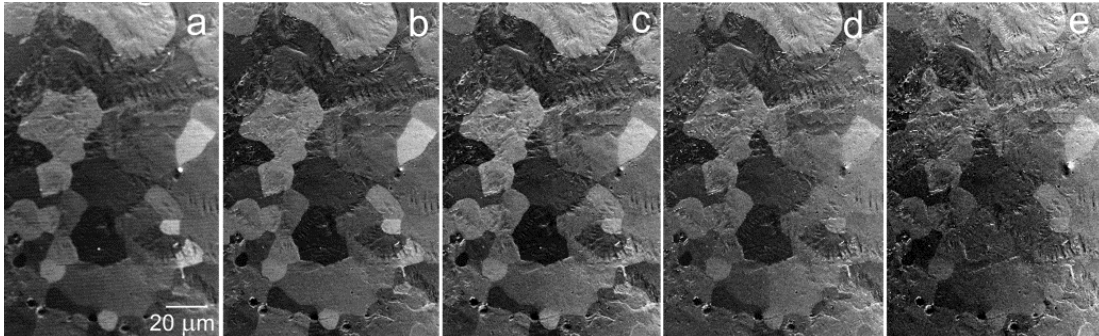
Figure 17. Polycrystalline Al, sample immersed in 1 kV/mm, landing energies of electrons as follows. ( a ) 2 eV; ( b ) 4 eV; ( c ) 7 eV; ( d ) 12 eV; ( e ) 20